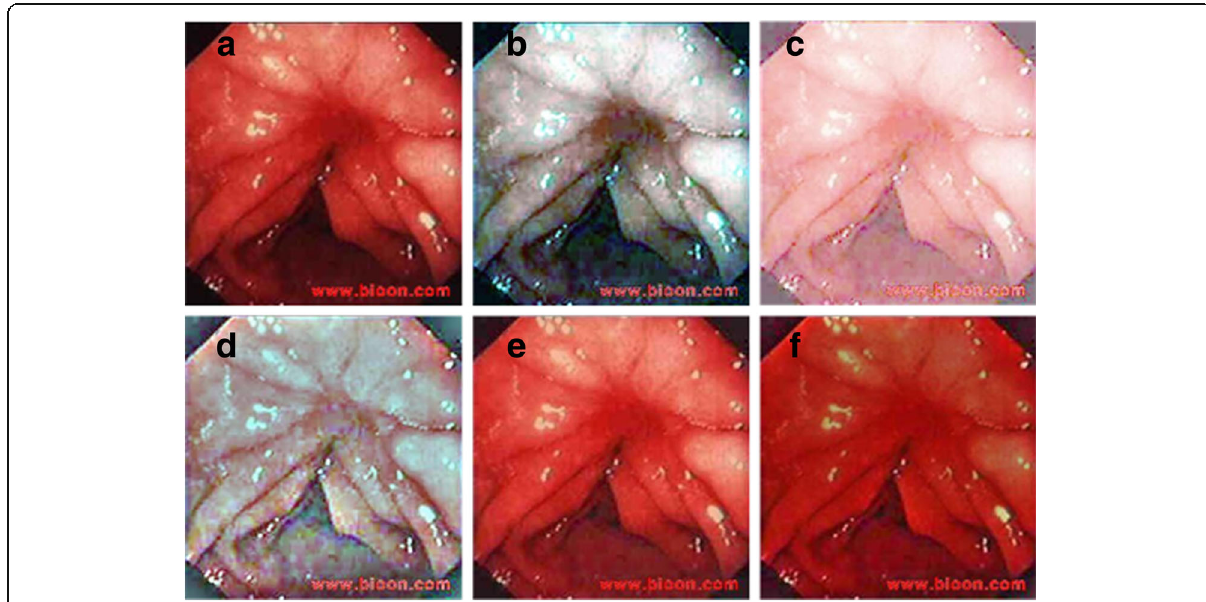
Fig. 9 Enhanced results using different methods. a Original image. b LHE. c MSR. d SARV. e NPEA. f AD- L 1 L 2